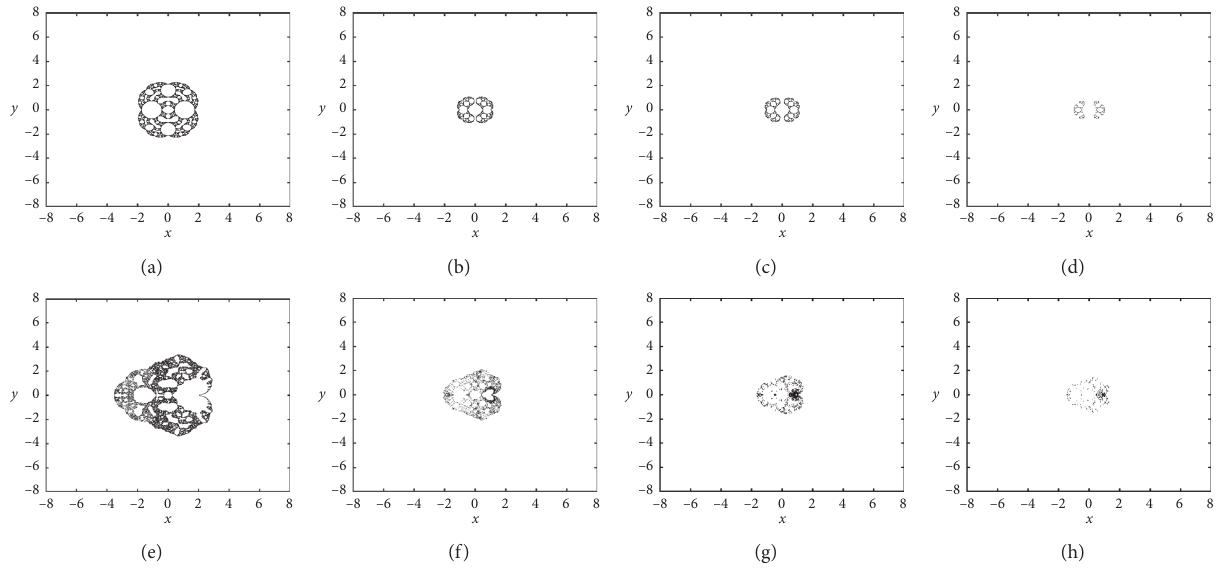
Figure 2: Changing of Julia sets of the discrete fractional system (15) with different values of control parameter k when μ � 2 and p � 2. (a) k � 0 . 2, (b) k � 0 . 6, (c) k � 0 . 65, (d) k � 0 . 9, (e) k � 0 . 1, (f) k � 0 . 4, (g) k � 0 . 6, and (h) k � 0 . 7.